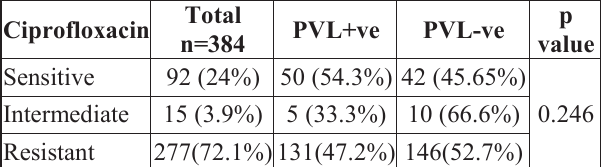
Table-1: Penton Valentine Leukocidin gene and